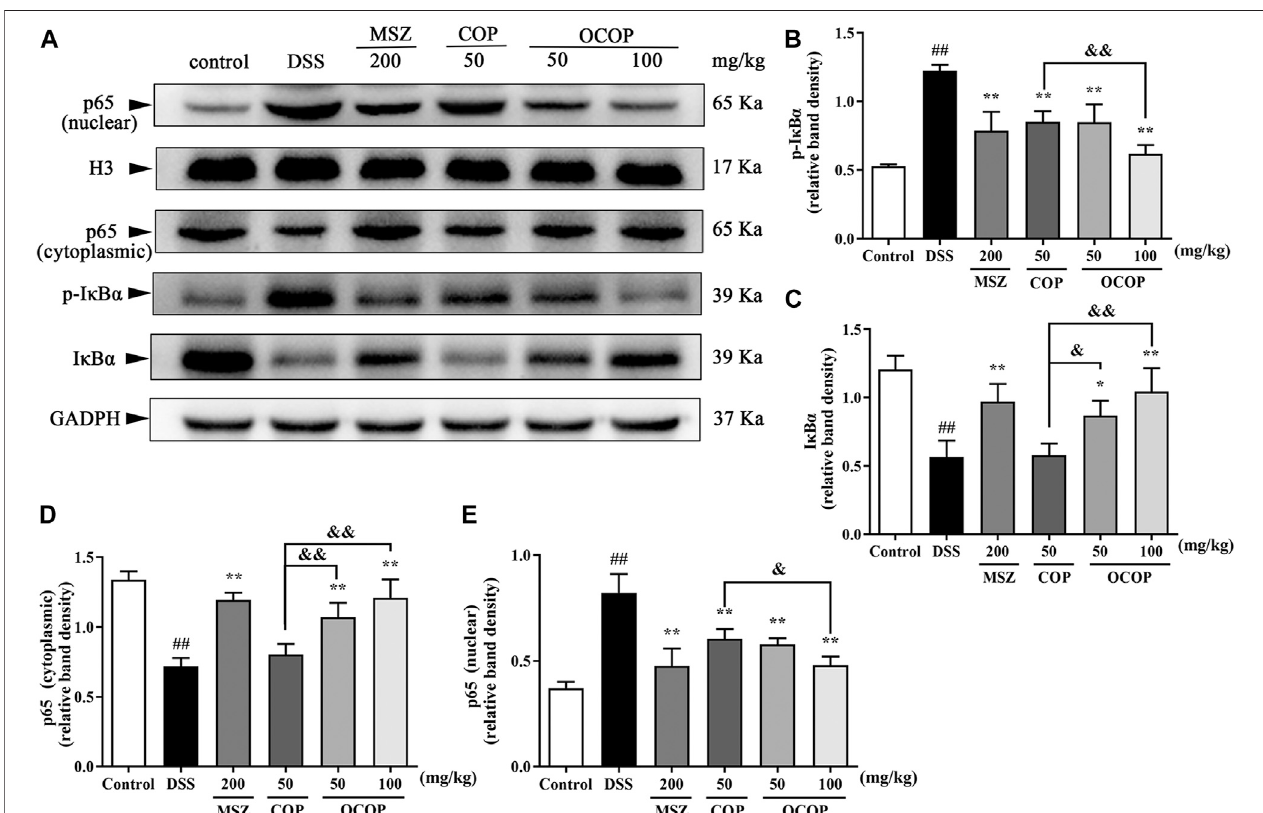
FIGURE 8 | Effects of OCOP and COP on the NF- κ B pathway in DSS-induced mice (A) Representative Western blotting images of pI κ B α , I κ B α , cytoplasmic p65 and nuclear p65 (B – E) The protein expression levels of pI κ B α , I κ B α , cytoplasmic p65 and nuclear p65 in the NF- κ B pathway. Data are expressed as the means ± SD (n (cid:2) 3). # p < 0.05, ## p < 0.01 vs. control group; * p < 0.05, ** p < 0.01 vs. DSS group; & p < 0.05, && p < 0.01 vs. COP